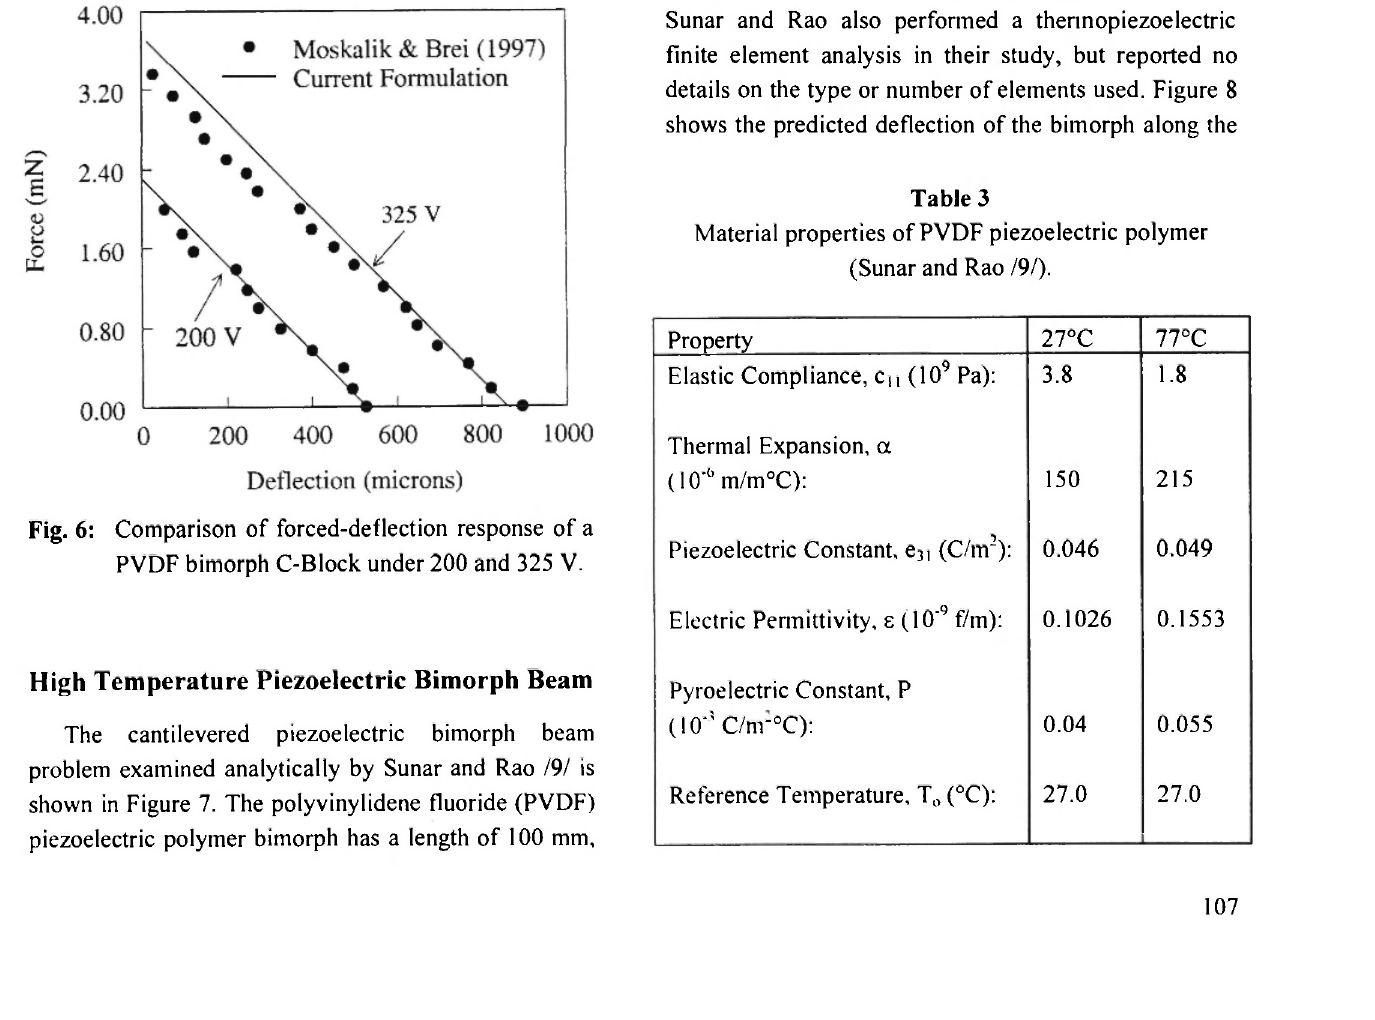
a width of 5 mm, and a height of 1 mm. An applied electric voltage of 250 Volts is applied to the bimorph beam at 27°C to induce a bending deformation. The impact of thermal effects on the deflection of the bimorph is subsequently examined by applying a uniform 50°C temperature increase. The material properties of the PVDF at 27°C and at 77°C are listed in 3. The current finite element analysis is performed using 20 elements along the length of the beam with two discrete layers through-the-thickness. Sunar and Rao also performed a therinopiezoelectric finite element analysis in their study, but reported no details on the type or number of elements used. Figure 8 shows the predicted deflection of the bimorph along the